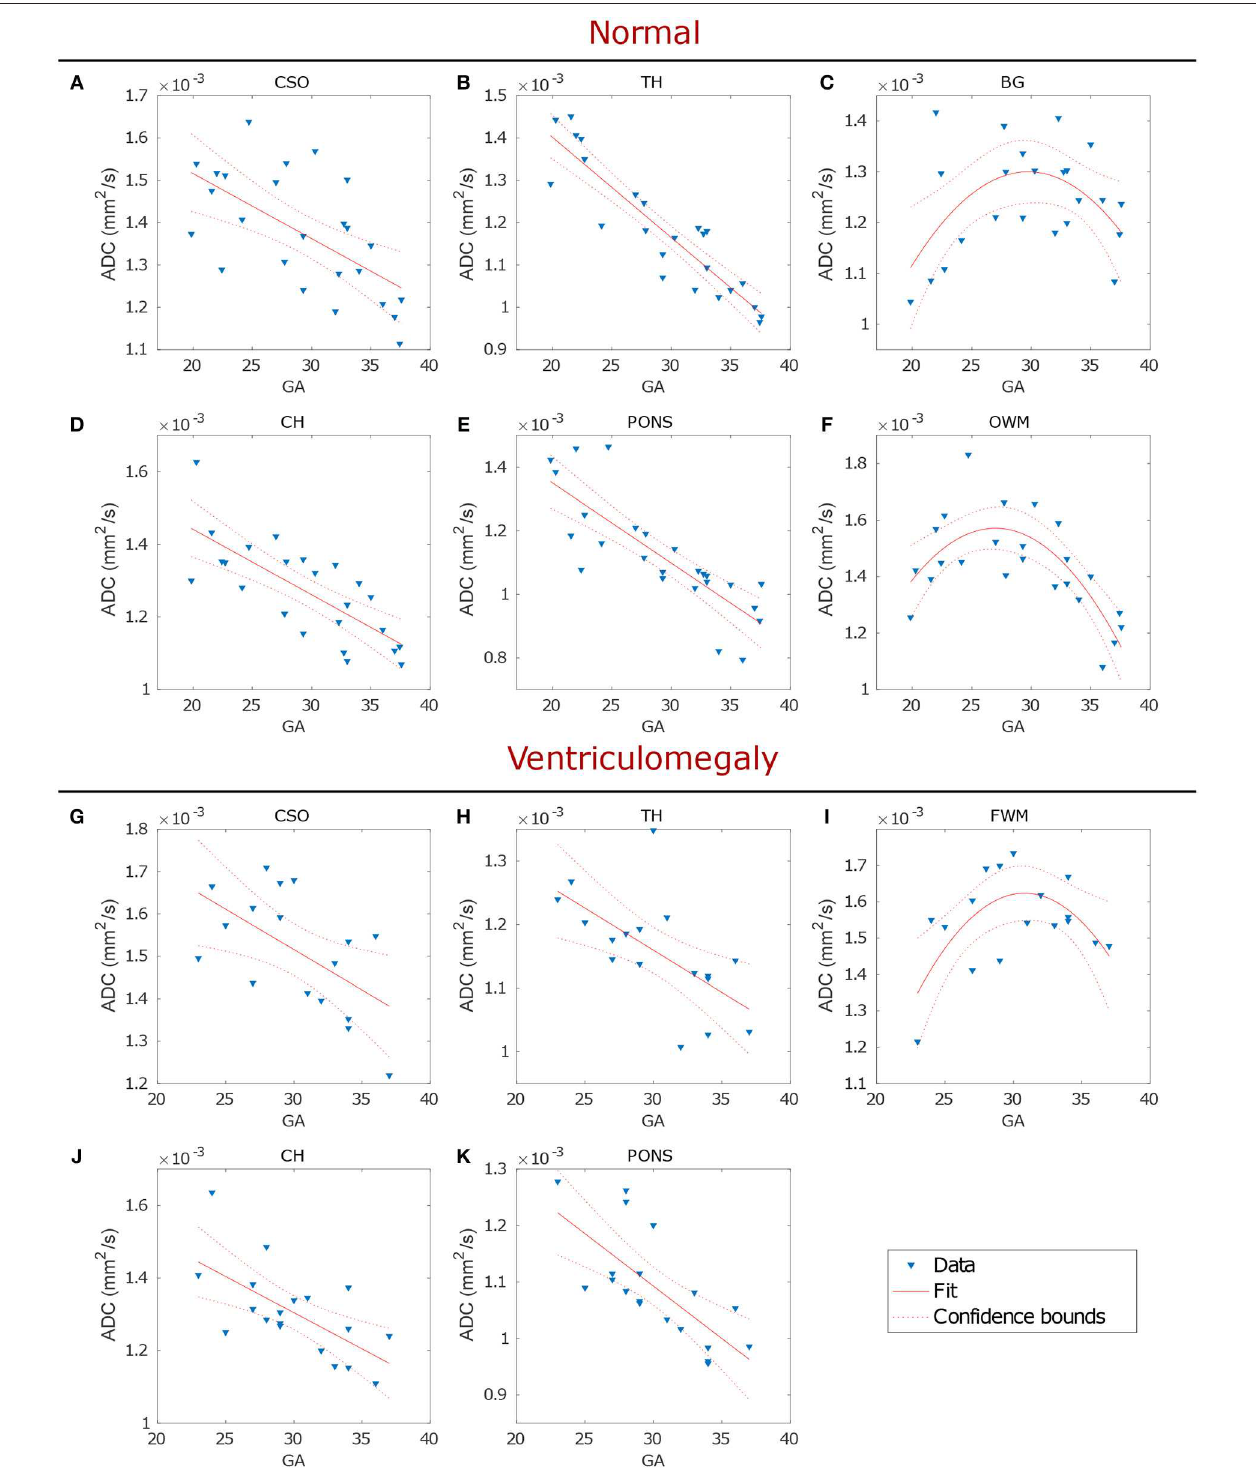
FIGURE 4 | Regression analysis of the ADC in normal (upper panel) and VM (lower panel) fetal brains showed the changes of biological water diffusion as a function of the gestational age (GA). Each plot, showing data fit and 95 % confidence interval, refers to a particular ROI: CSO, TH, BG, CH, pons and OWM of normal brains ( A–F , respectively) and CSO, TH, FWM, CH, and pons of VM cases ( G–K , respectively).